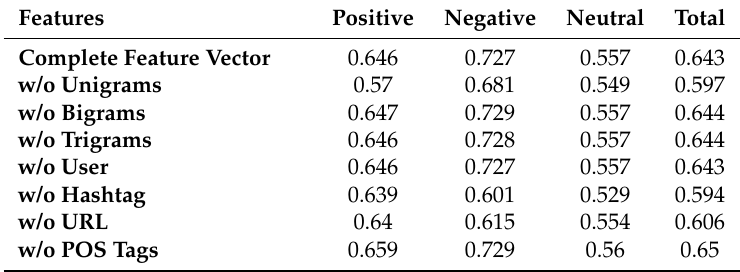
Table 11. F-Measure for Ternary Classification for Decision Trees for 12,500